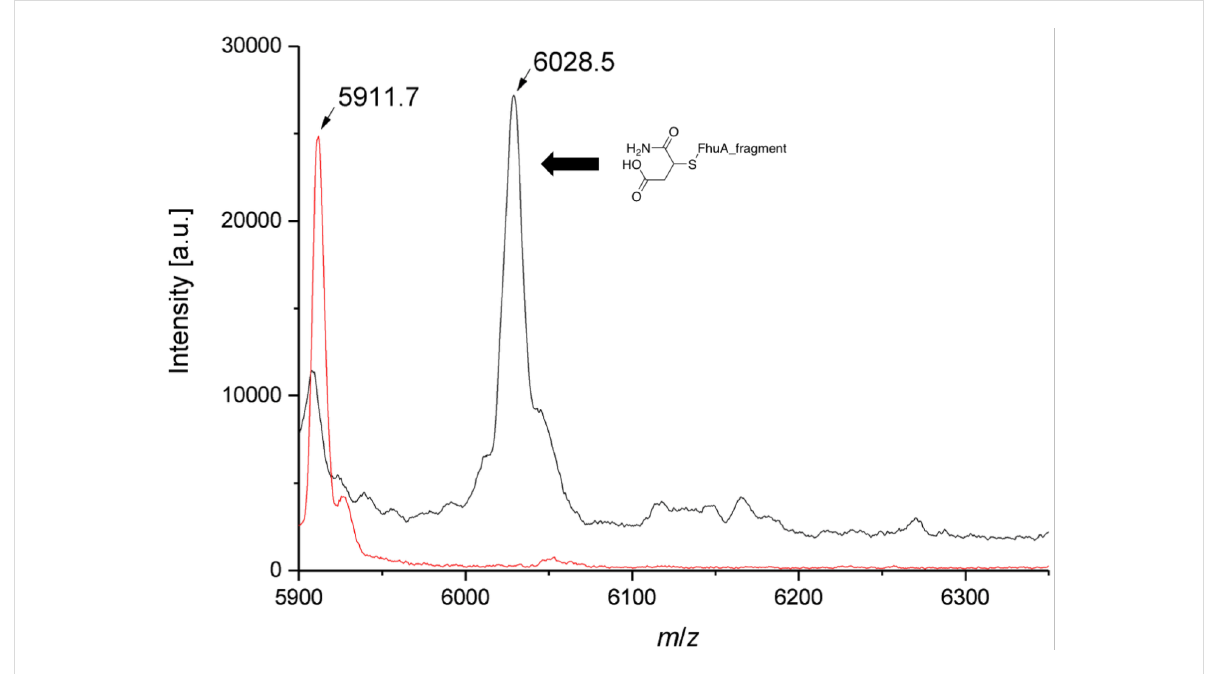
Figure 4: MALDI–TOF mass spectra of apo FhuA Δ CVF tev (red; calculated m / z = 5902.6; found: m / z = 5911.7) and 2 (black; m / z = 6028.5 is assigned to the FhuA fragment containing the maleimide function after water addition). Possible fragmentation of the [Rh] catalyst is indicated. FhuA Δ CVF tev was analyzed after digestion by protease from Tobacco Etch Virus (TEV).